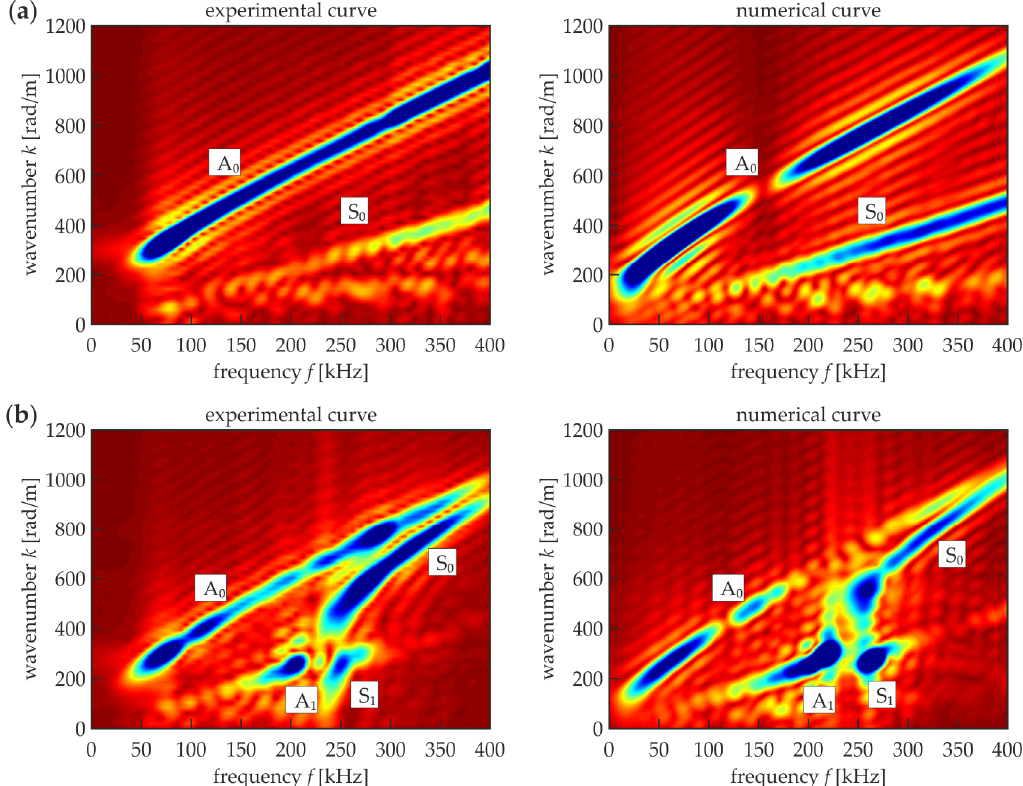
Figure 6. Experimental and numerical dispersion curves: ( a ) steel plate (sample D1)—single layer medium ( d s = 3 mm, E s = 195.2 GPa, vs. = 0.3, ρ s = 7741.7 kg/m 3 ); ( b ) adhesive joint (sample D2)—three-layer medium consisted of two steel plates (parameters same as in ( a )) and adhesive film ( d a = 0.2 mm, E a = 5 GPa, v a = 0.35, ρ a = 1330 kg/m 3 ).